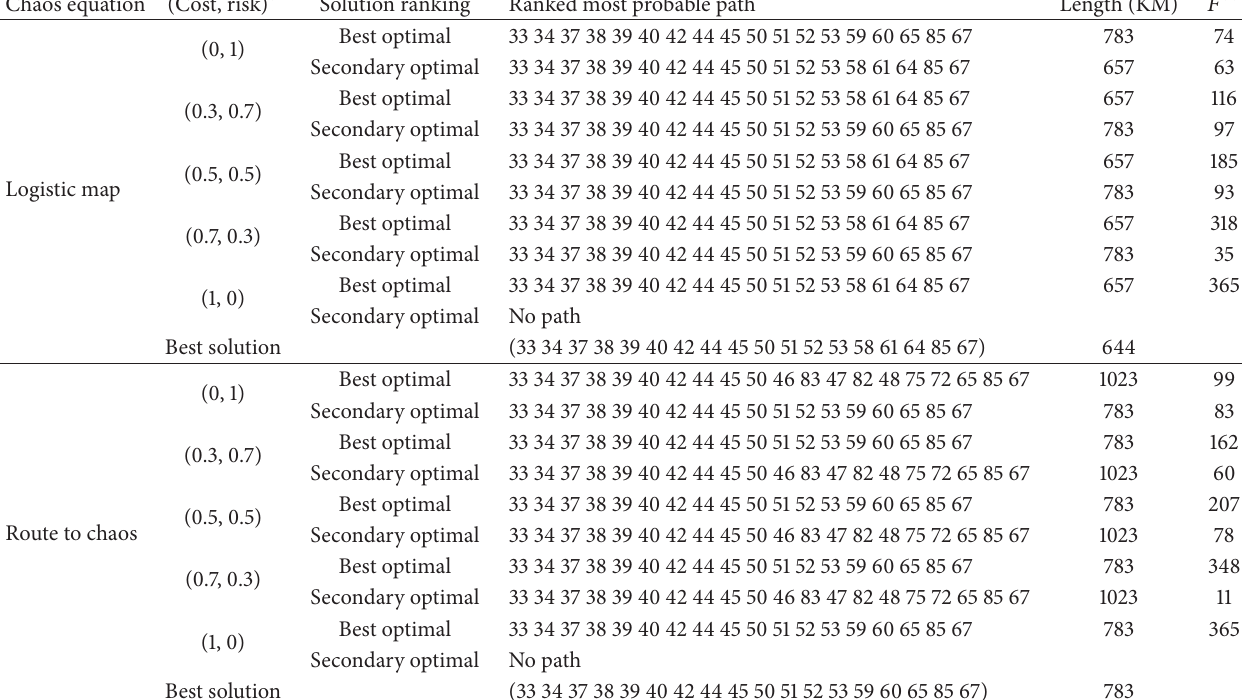
Table 2: Best and secondary optimal paths and their lengths from Ardabil (node 33) to Sanandaj (node 67). Chaos equation (Cost, risk) ∗ Solution ranking Ranked most probable path Length (KM) 𝐹 ∗∗